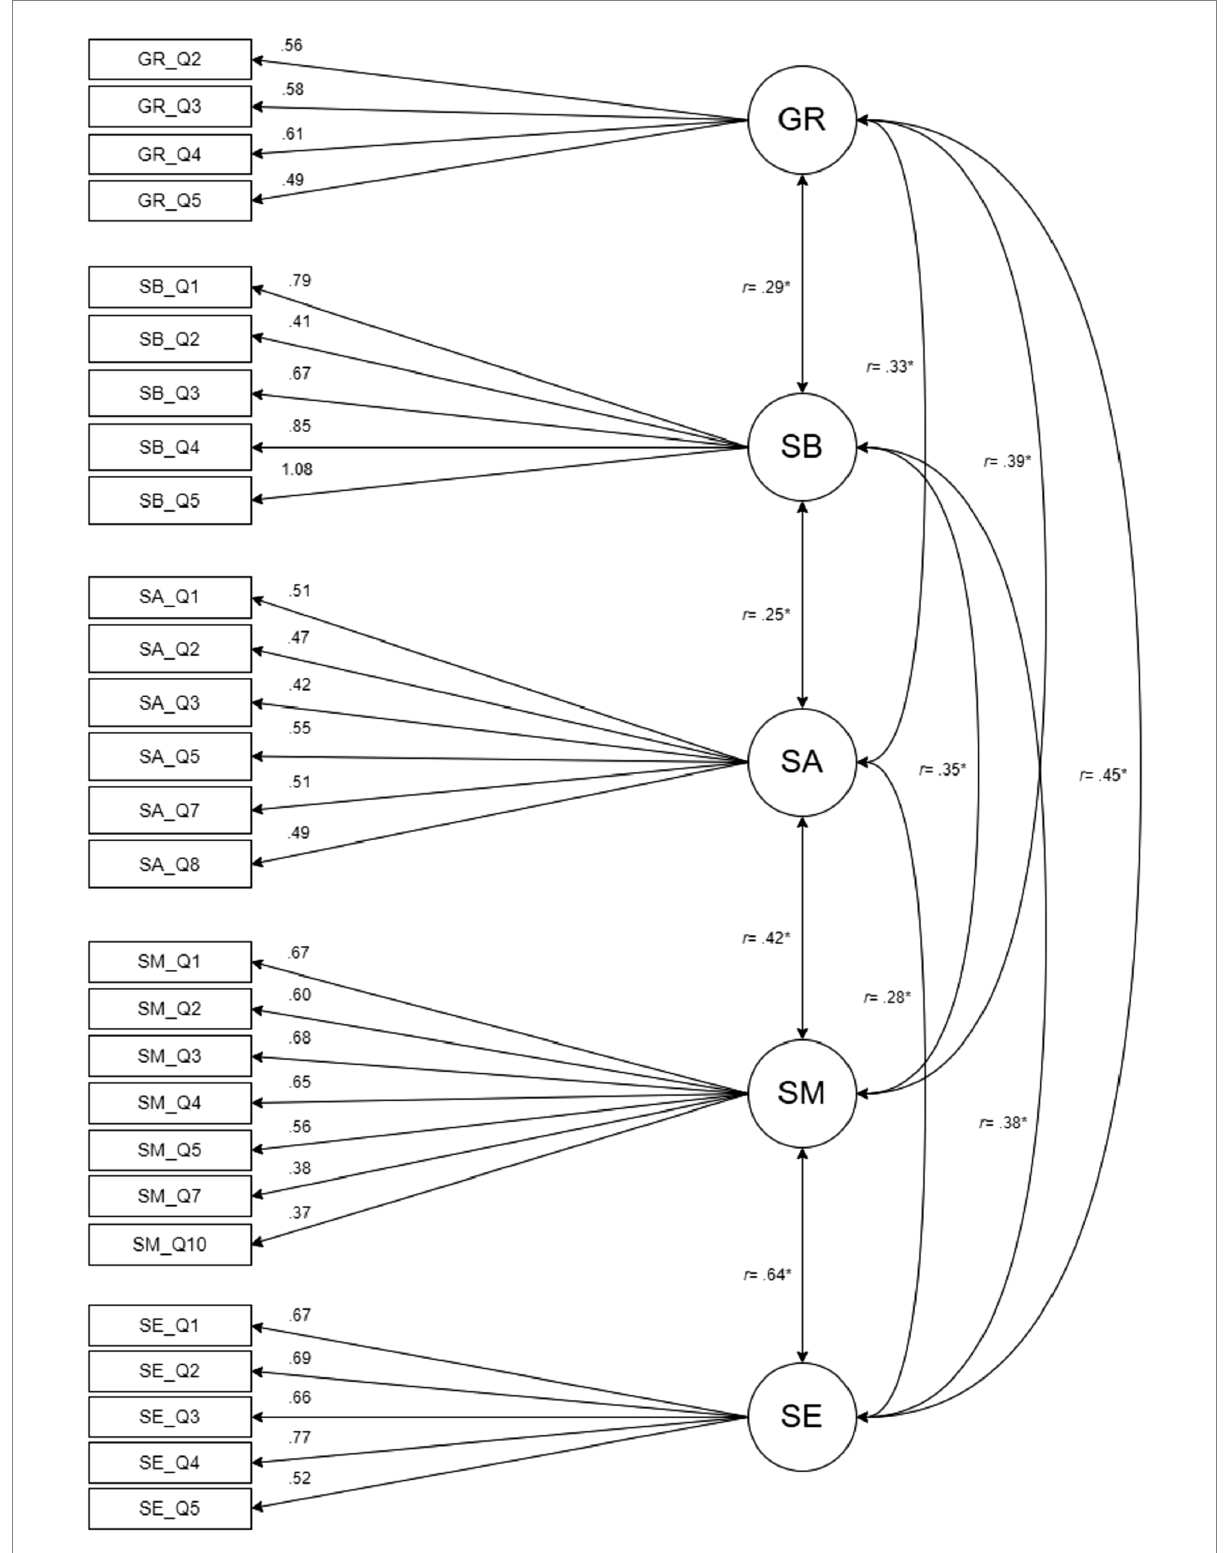
FIGURE 1 CFA with factor loadings from model 2 (5 factors, 27 items). Loadings are standardized. Rectangles indicate measured variables and circles represent latent constructs. Note the item numbering is retained from the original 33-item scale. * p < 0.001. GR, grit; SB, sense of belonging; SA, social awareness; SM, self-management; SE,